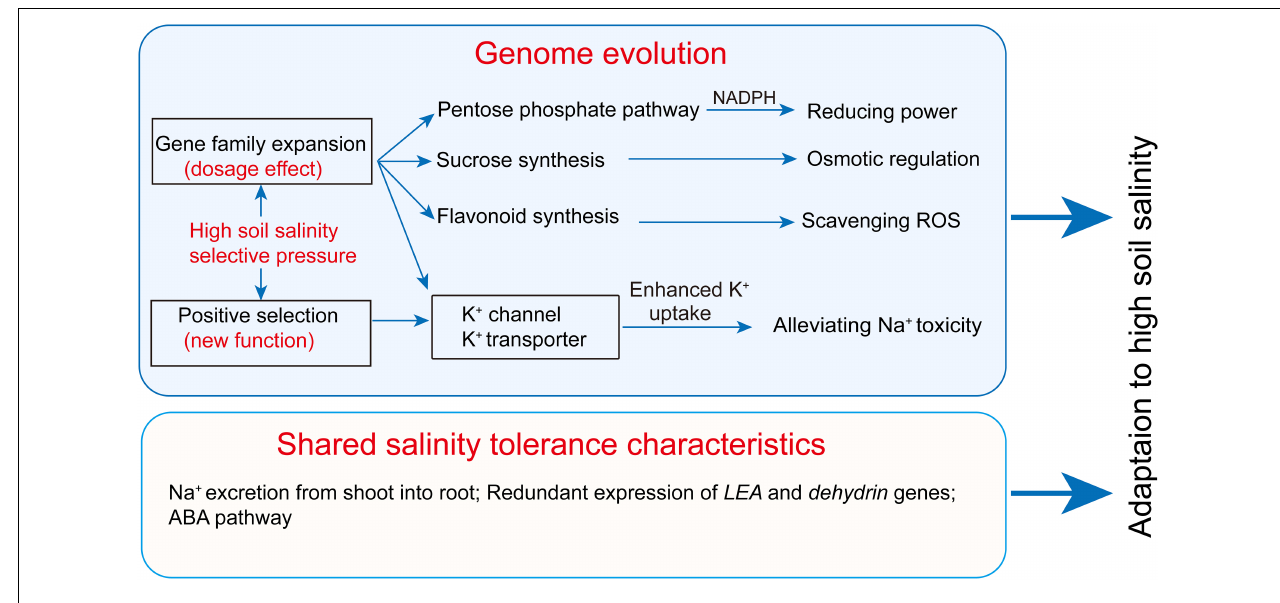
FIGURE 7 | Genomic mechanisms of salinity tolerance evolution in P. tenuiflora . LEA, late embryogenesis abundant protein; ROS, reactive oxygen